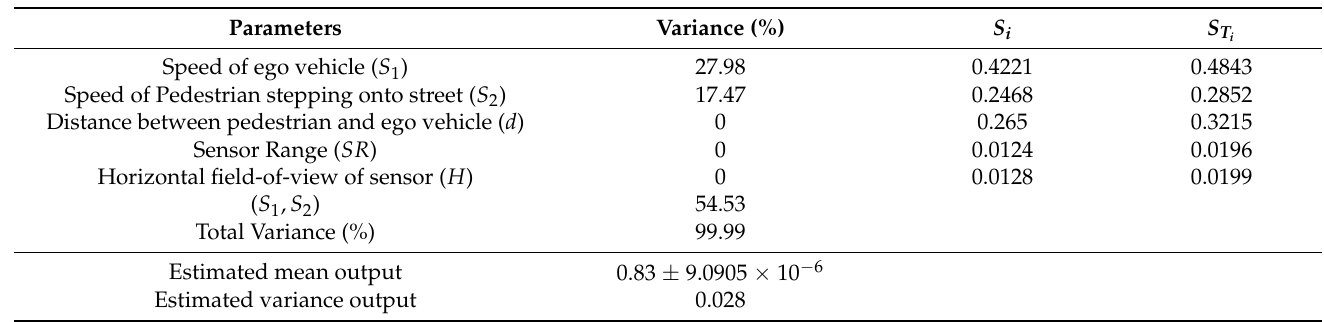
Figure 5. The estimated main effects, 1st and 2nd order sensitivity indices of the parameters in the pedestrian step-out scenario as discussed in Table 1. Table 2. The emulator-based sensitivity analysis (SA) of the pedestrian step-out scenario (c.f. Section